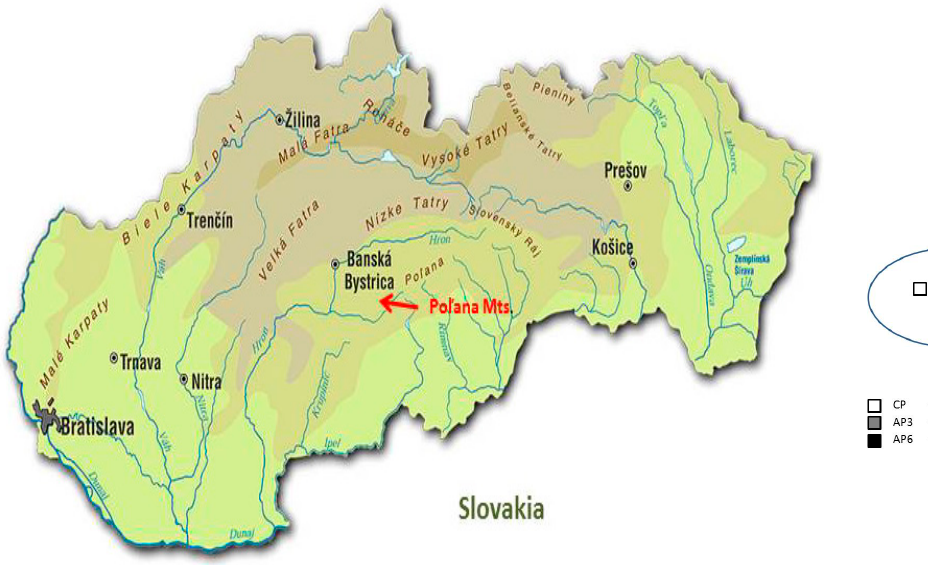
Figure A1. Localization of the research area and scheme of the distribution of research plots.